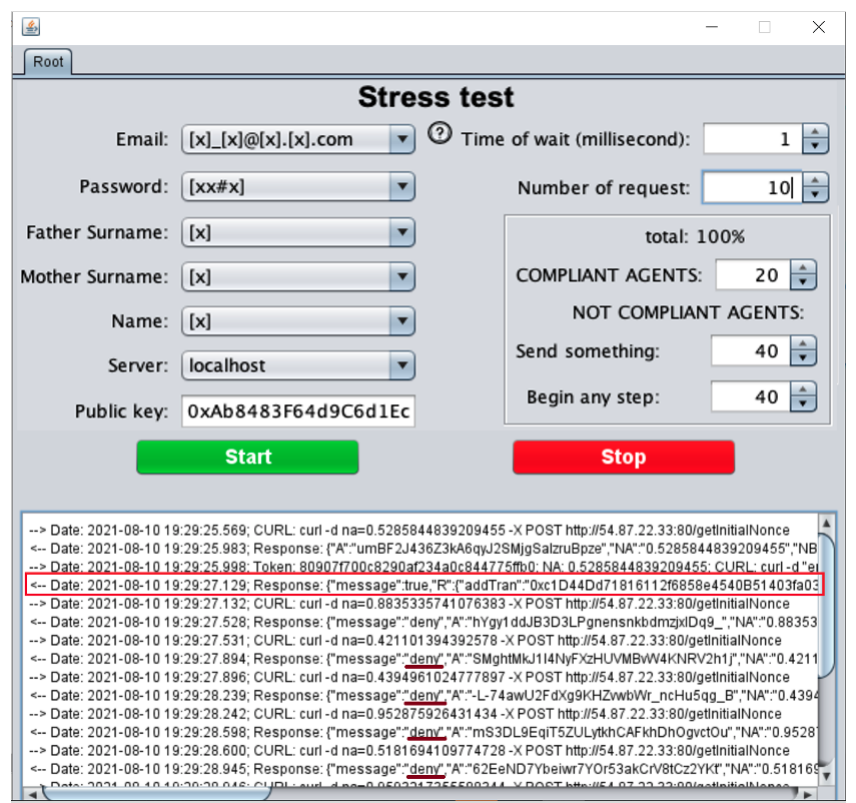
Figure 12. User interface to test the creation of the